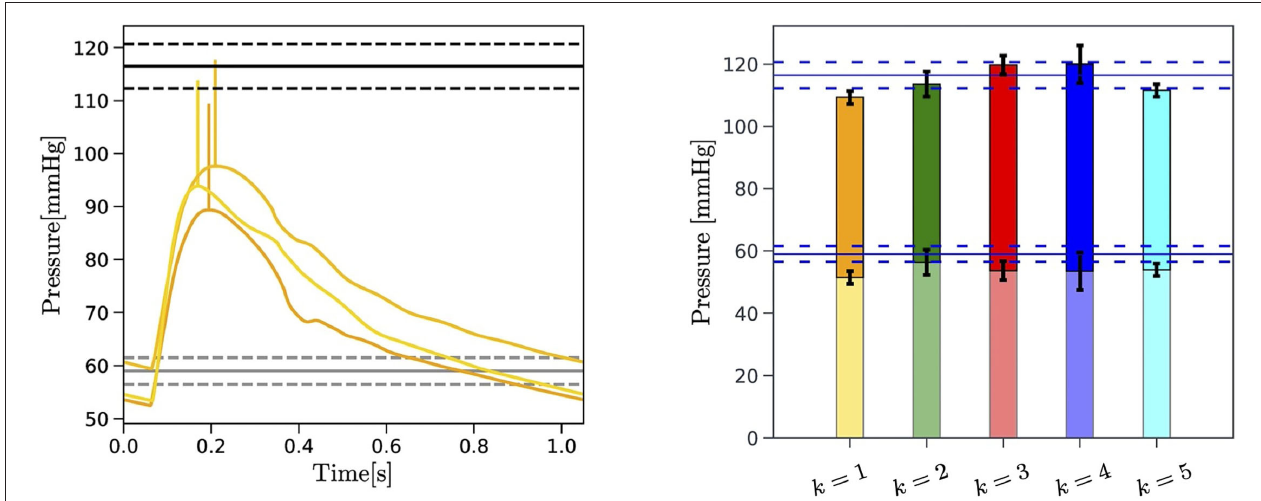
FIGURE 6 | Left: Comparison between the central aortic pressure corresponding to the three best-ranked curves selected by the EA search performed on f M 1 for Subject 1 (yellow curves) and the blood pressure measured at the arm with a cuff of the subject (horizontal black lines). The 20 mmHg increment applied to the systolic value of predicted central aortic pressure is also indicated (vertical yellow segments). The mean (solid black lines) maximum and minimum value (dashed black lines) of the repeated blood pressure measurements are reported. Right: Comparison between the experimentally measured brachial pulse pressure (PP) (horizontal blue lines) and the brachial pressure predicted by the EA for each of the k = 1, ... ,5 objective curves for Subject 1. The PP is indicated with solid colors. Maximum and minimum values obtained for the three best-ranked curves for each f M k , with k = 1, ... , N c , are reported in black brackets.